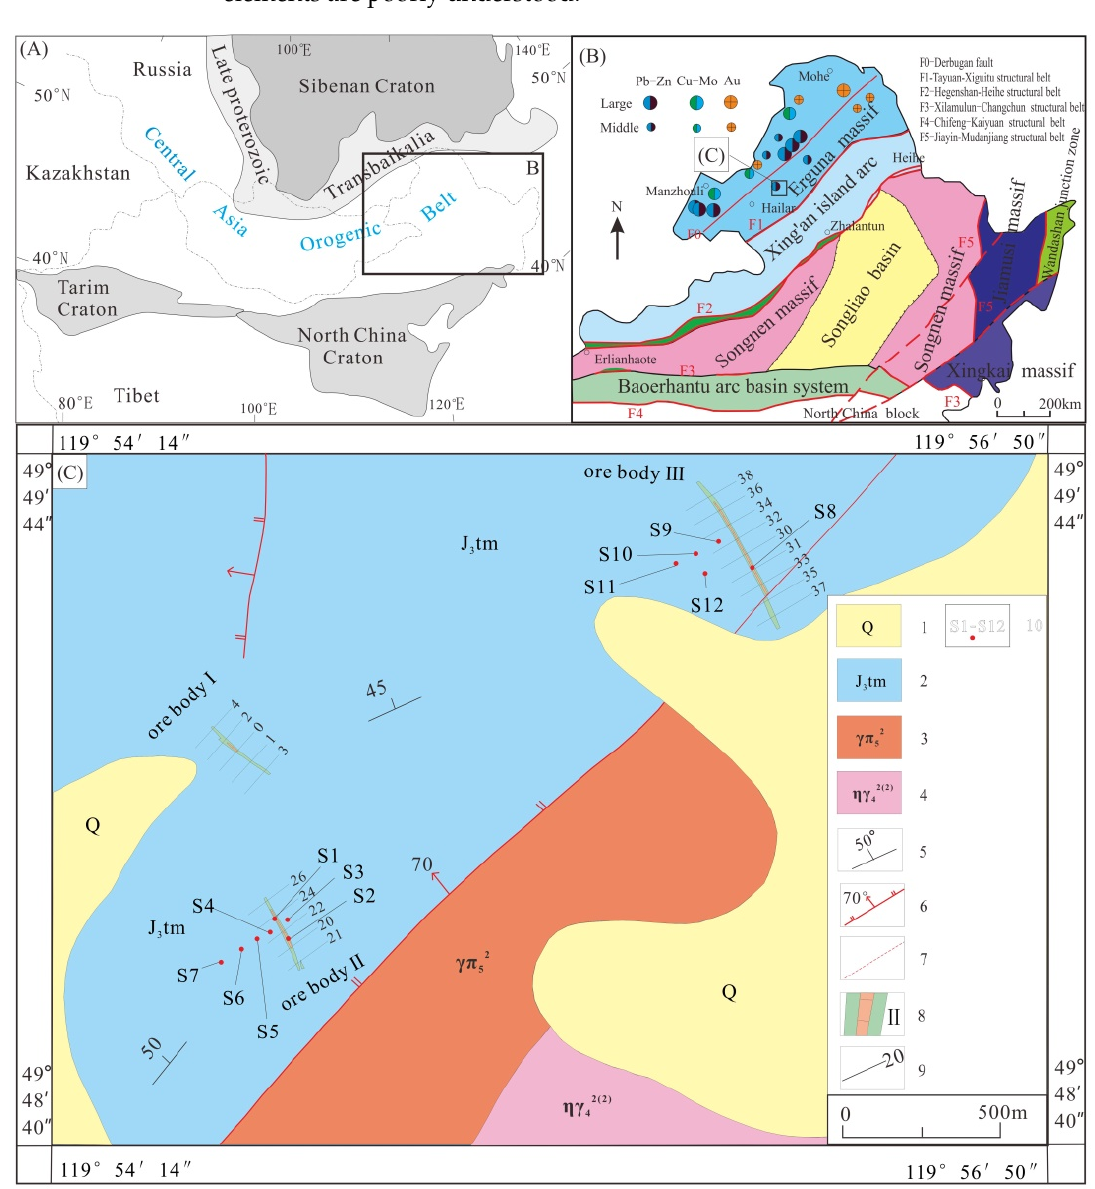
Figure 1. Geotectonic location map (( A ) after [14]; ( B ) modified by [15]) and geological map (( C ) after [16]) of the Qiyimuchang deposit. 1—Quaternary alluvium deposits; 2—Tamulangou formation of upper Jurassic; 3—Early Yanshanian granite porphyry; 4—Middle Variscan porphyry biotite monzogranite; 5—Strata occurrence(tuff in late Jurassic); 6—Measured normal fault and its dip angle; 7—Concealed fault; 8—Ore body and its number; 9—Prospecting line and its number; 10—Sampling location and its number; S1—13QYK1 and samples for S and Pb isotopes; S2—13QYK2 and samples for S and Pb isotopes; S3—14QY; S4—13QY6; S5—13QY25 and the sample for U-Pb Dating; S6—13QY16; S7—13QY11; S8—13QYK3 and samples for S and Pb isotopes; S9—13QY2-1; S10—13QY2-2; S11—13QY3;